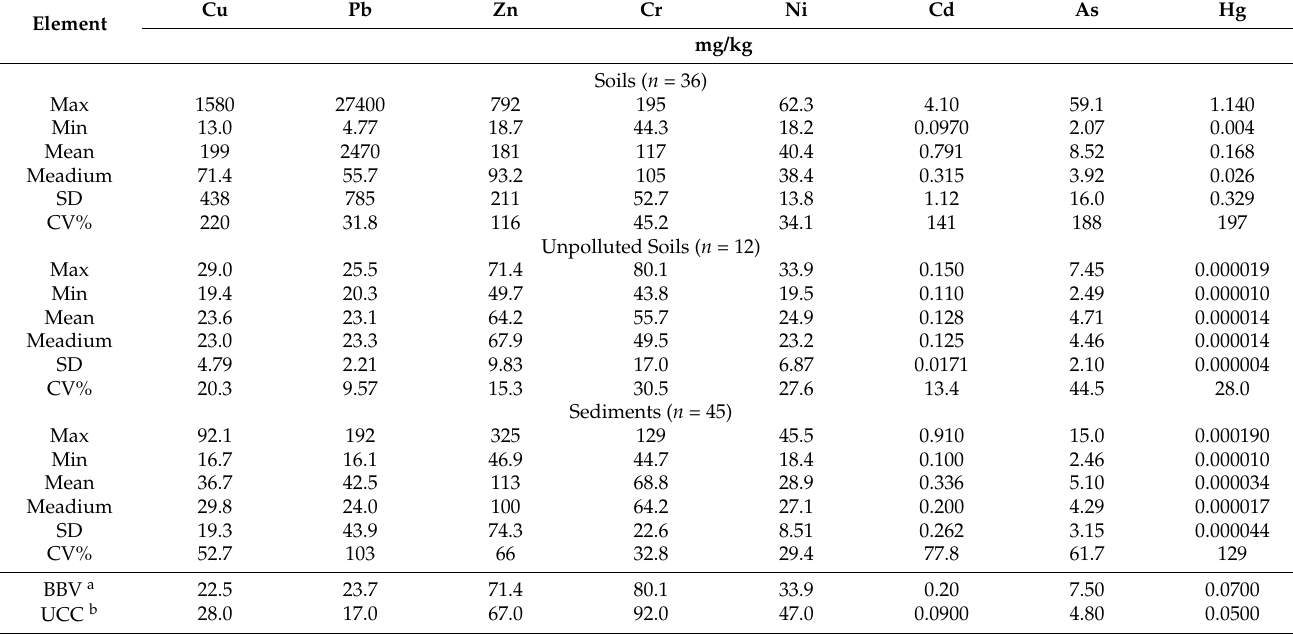
Table 1. Concentration of PTEs in soils, unpolluted soils, and sediments.